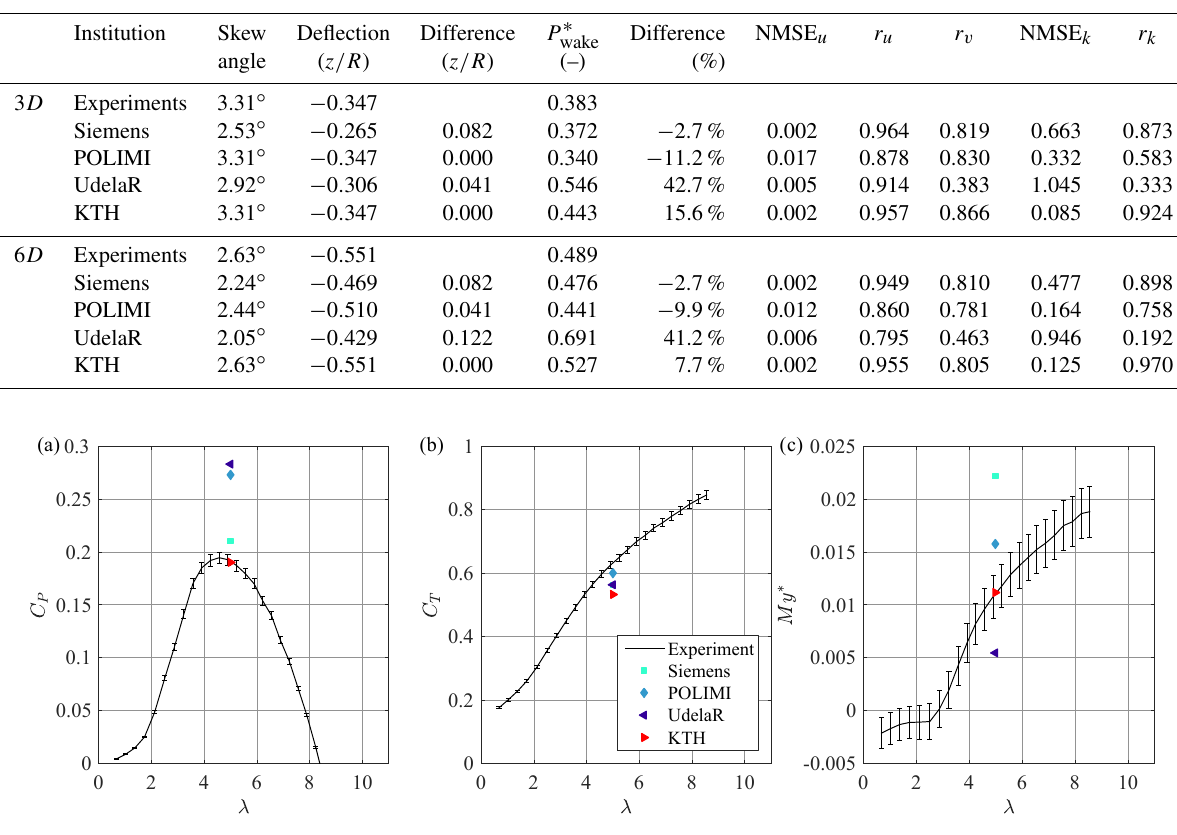
Figure 10. Power coefficient C P , T2 (a) , thrust coefficient C T , T2 (b) and normalized yaw moment M ∗ turbine operated in the wake of LARS1 at γ T2 = 0 ◦ for λ T2 = 1 to